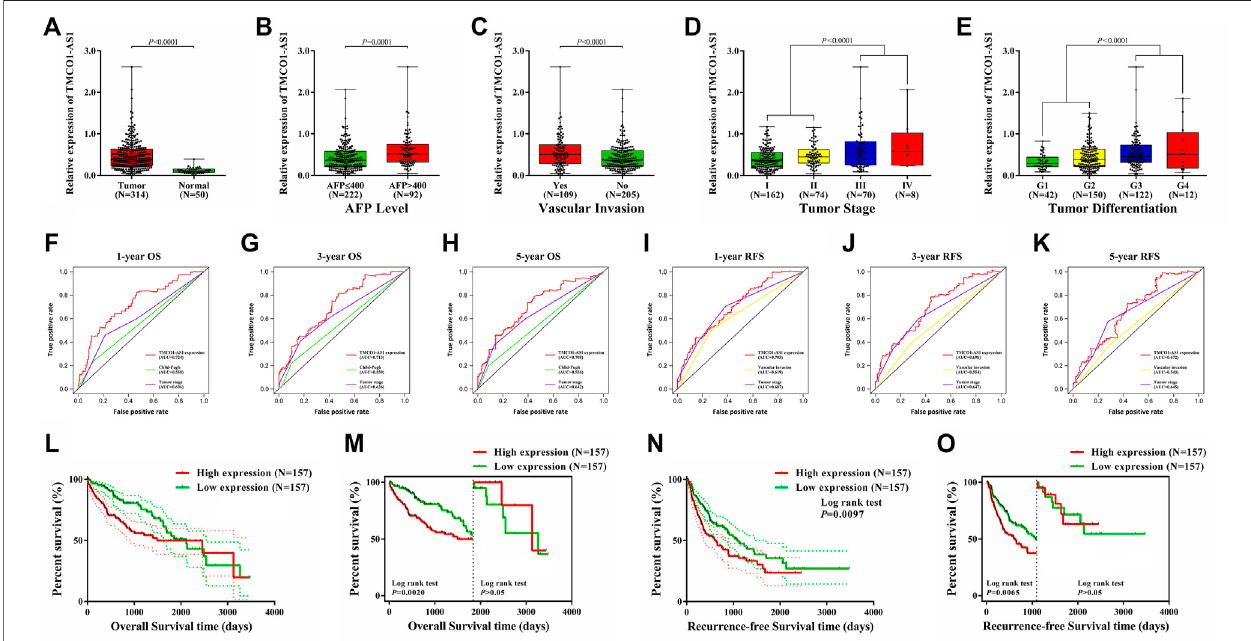
FIGURE2| DysregulationofTMCO1-AS1 inHCC and its prognostic signi fi cance for HCC using data ofpatients from TCGA. (A) The expression levels ofTMCO1- AS1 in HCC and adjacent normal tissues. (B) TMCO1-AS1 expression in patients with high (AFP > 400 μ g/L) and low (AFP ≤ 400 μ g/L) serum AFP levels. (C) TMCO1- AS1 expression in patients with and without vascular invasion. (D) TMCO1-AS1 expression in patients with different tumor stages. (E) TMCO1-AS1 expression in patients with different degrees of tumor differentiation. (F – H) Time-dependent ROC curves of the relations of clinical characteristics and 1-/3-/5-year OS. (I – K) Time-dependent ROC curves of the relations of clinical characteristics and 1-/3-/5-year RFS. (L) Kaplan-Meier curves for OS of HCC patients from TCGA with high and lowTMCO1-AS1expression. (M) Landmarkanalysisdiscriminating betweenOSbeforeand after5 yearsoffollow-up. (N) Kaplan-Meier curvesforRFS ofHCC patients from TCGA with high and low TMCO1-AS1 expression. (O) Landmark analysis discriminating between RFS before and after 3 years of